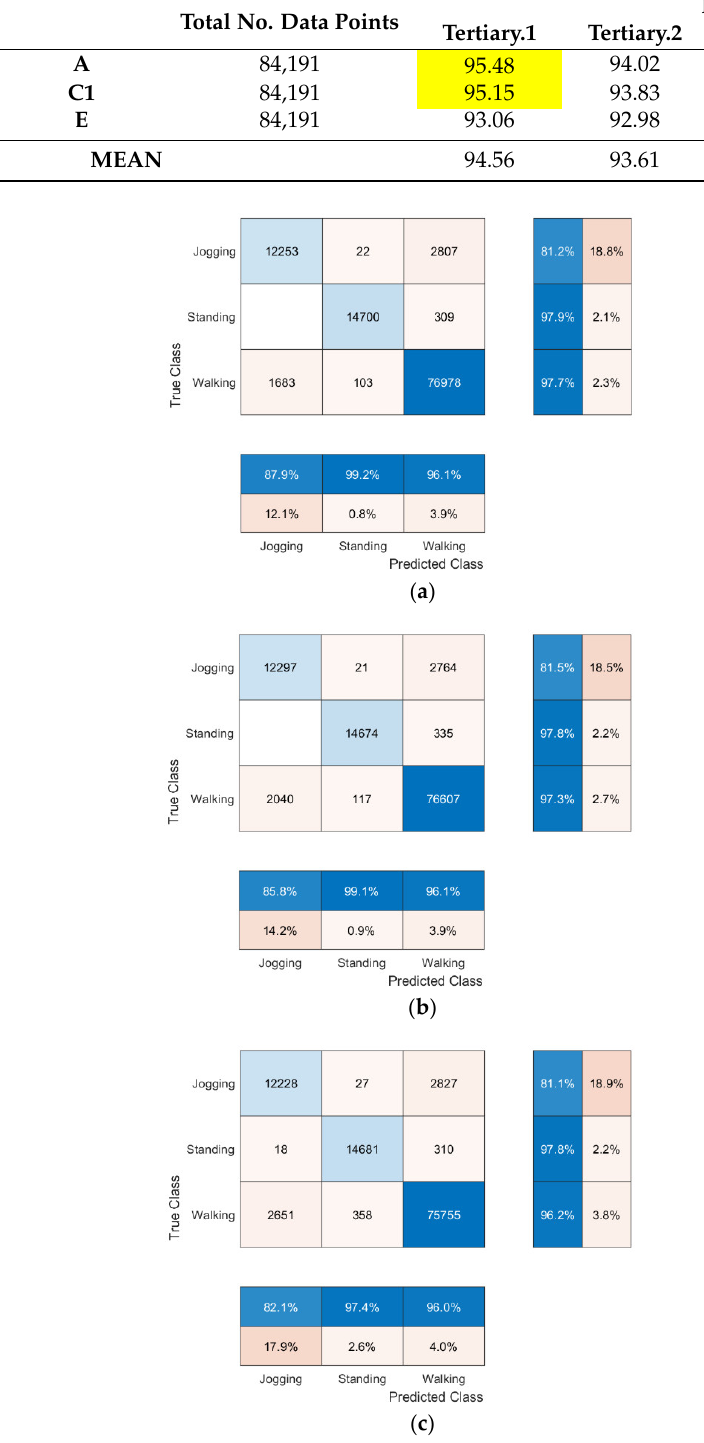
Figure 2. Confusion matrices for ( a ) Tertiary Classifier, Feature Set A, Model.1 (k-NN Manhattan Classifier). ( b ) Tertiary Classifier, Feature Set C1, Model.1 (k-NN Manhattan Classifier). ( c ) Tertiary Classifier, Feature Set A, Model.3 (Decision Tree Classifier).